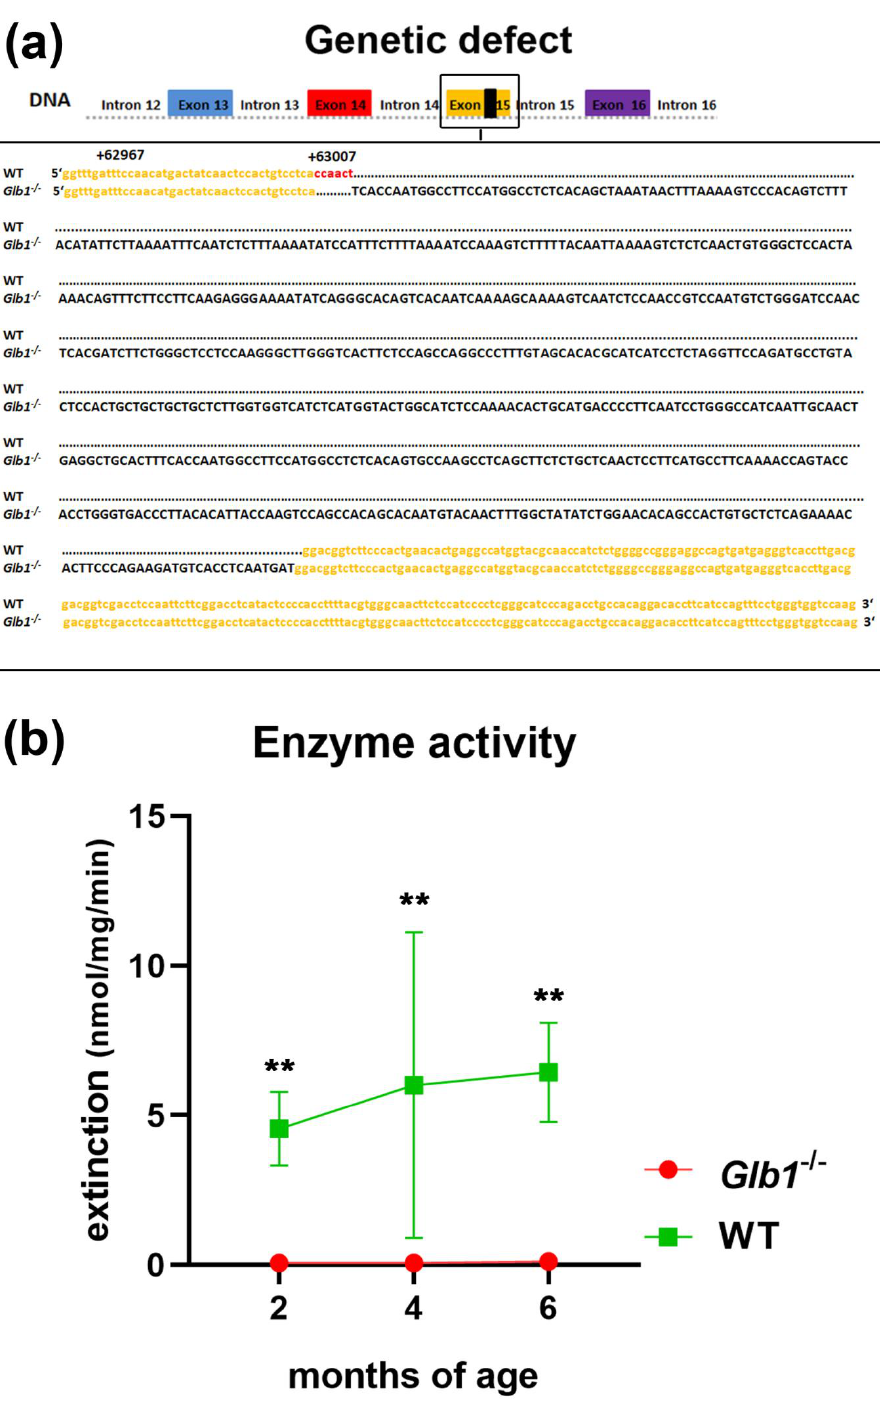
Figure 1. Sequence of the Glb1 − / − mice in exon 15 with the insert and enzyme activity of the β -galactosidase. ( a ) DNA sequence of parts of the exon 15 (yellow) with the knock-in (black). ( b ) Minimal β -galactosidase enzyme activity in Glb1 − / − mice compared to wildtype (WT) control mice. ** p < 0.01. Graphs represent mean ± SD; n = 2 (WT at two and four months of age, Glb1 − / − at four and six months of age), n = 3 ( Glb1 − / − at two months of age), n = 4 (WT at six months of